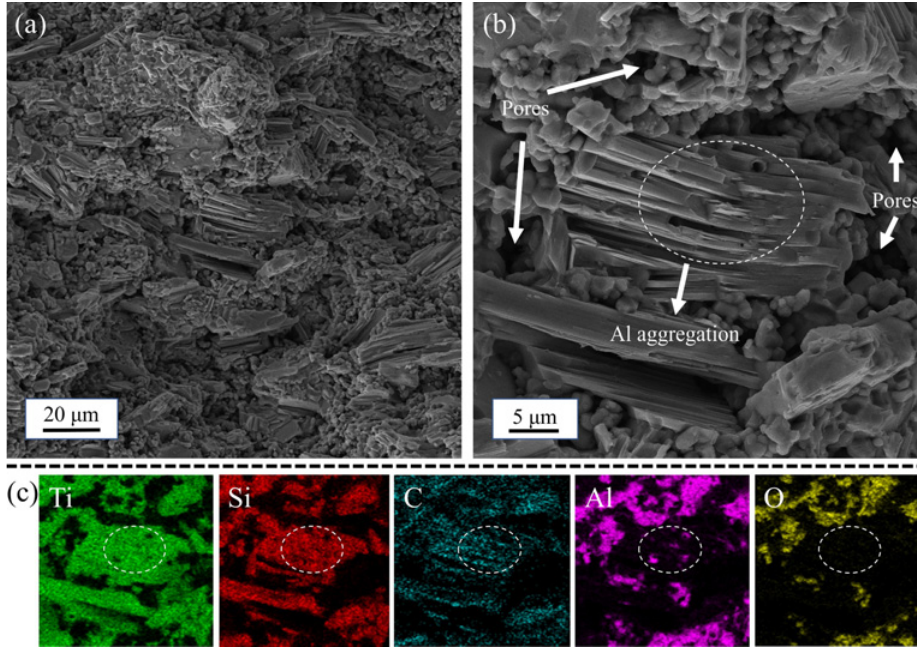
Fig. 3 Microstructures of the HP sample: (a) low-magnification SEM image and (b) high-magnification SEM image with (c) corresponding elemental distributions.